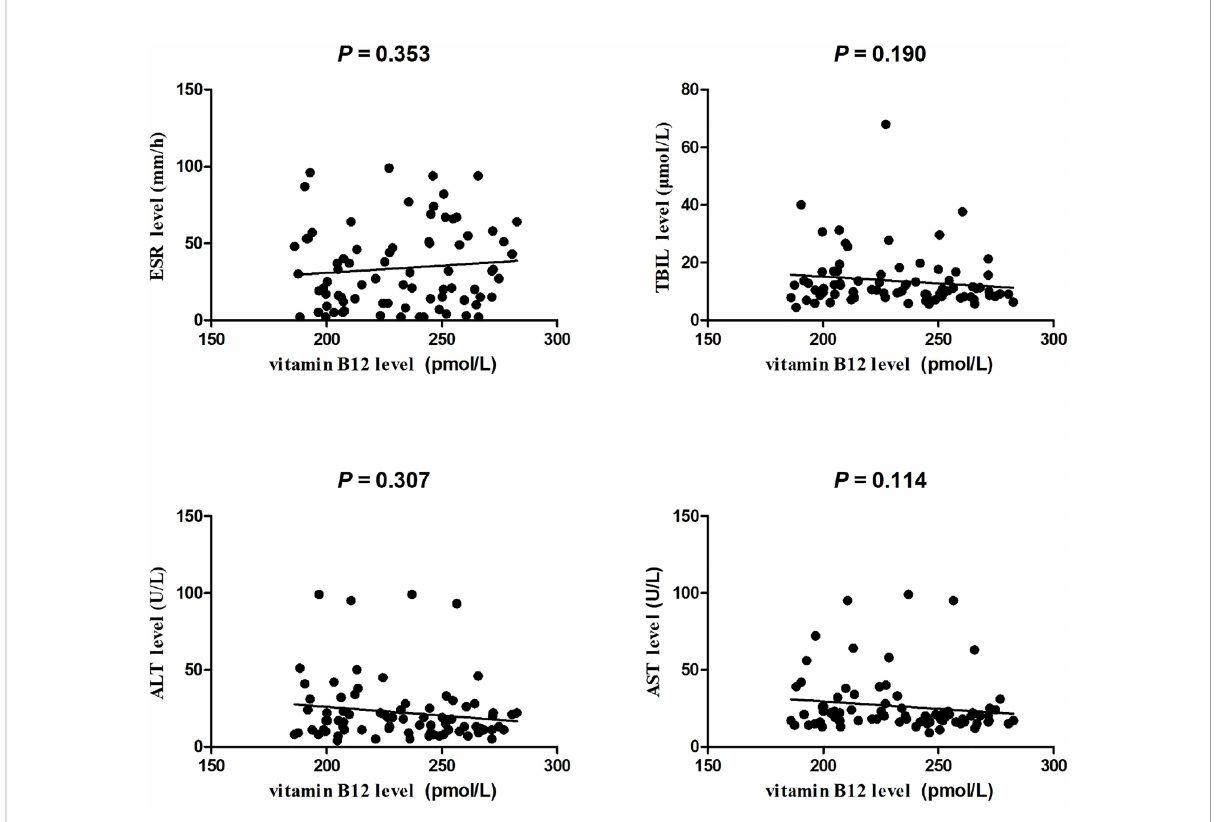
FIGURE 2 The correlation between ESR, TBIL, ALT, AST levels, and plasma vitamin B12 level in patients with